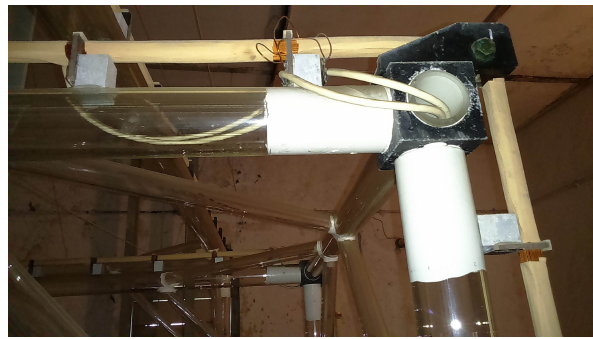
Figure 5. Tri-axial square Helmholtz coil calibration facility at Al- ibag Magnetic Observatory.